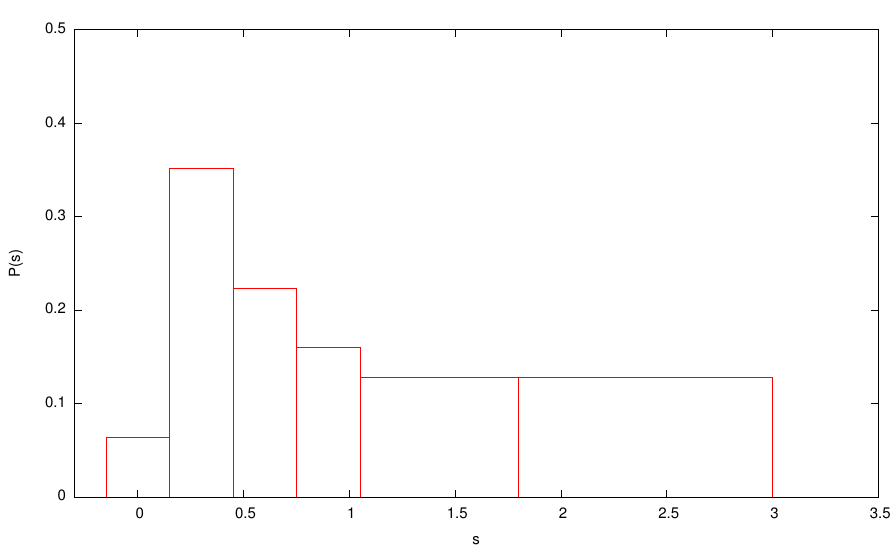
Figure 7 . Level spacing distribution for the unfolded spectrum. The vertical axis P ( s ) has been scaled for convenience and this does not a(cid:11)ect any of our discussions as we are mainly interested in turn around near s ! 0. This turn around suggests level